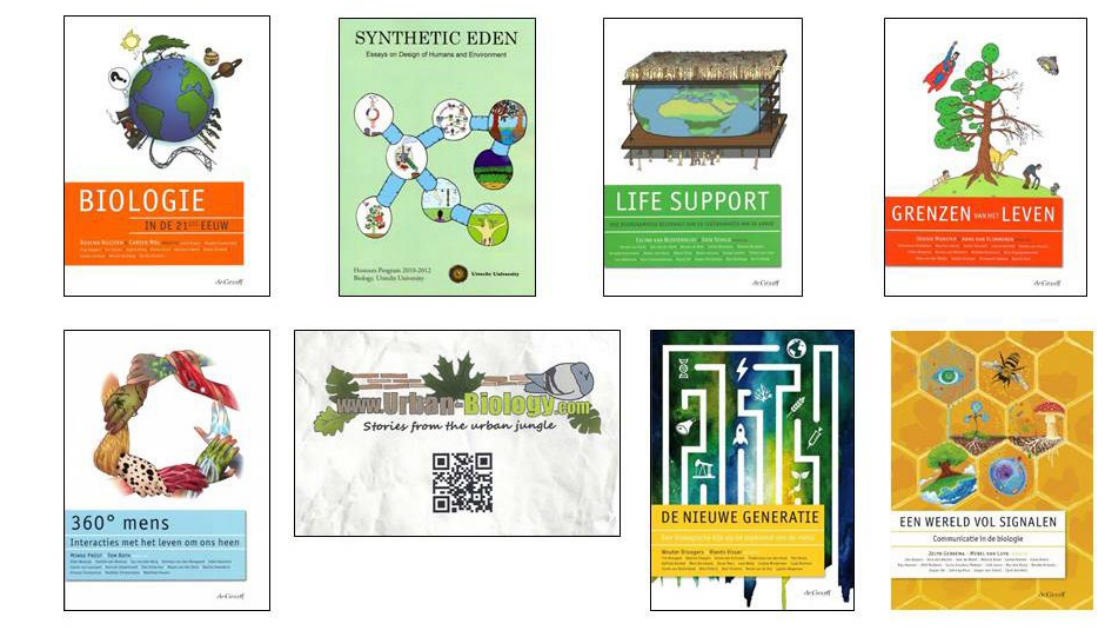
Figure 1. The covers of the popular science books as well as a website that have been produced by honors students at the Department of Biology, Utrecht University, over the past 8 years. Most books are available at Uitgeverij de Graaff in Utrecht, The